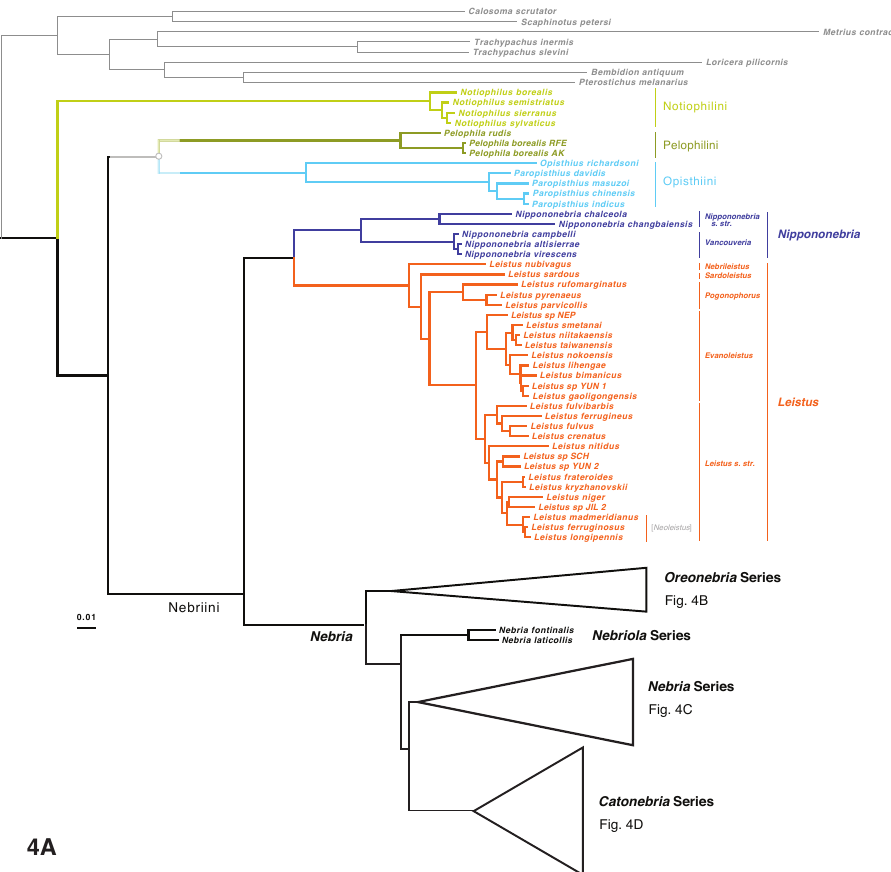
Figure 4. Maximum likelihood tree for concatenated matrix of all genes. Scale bar: 0.1 units, as esti- mated by